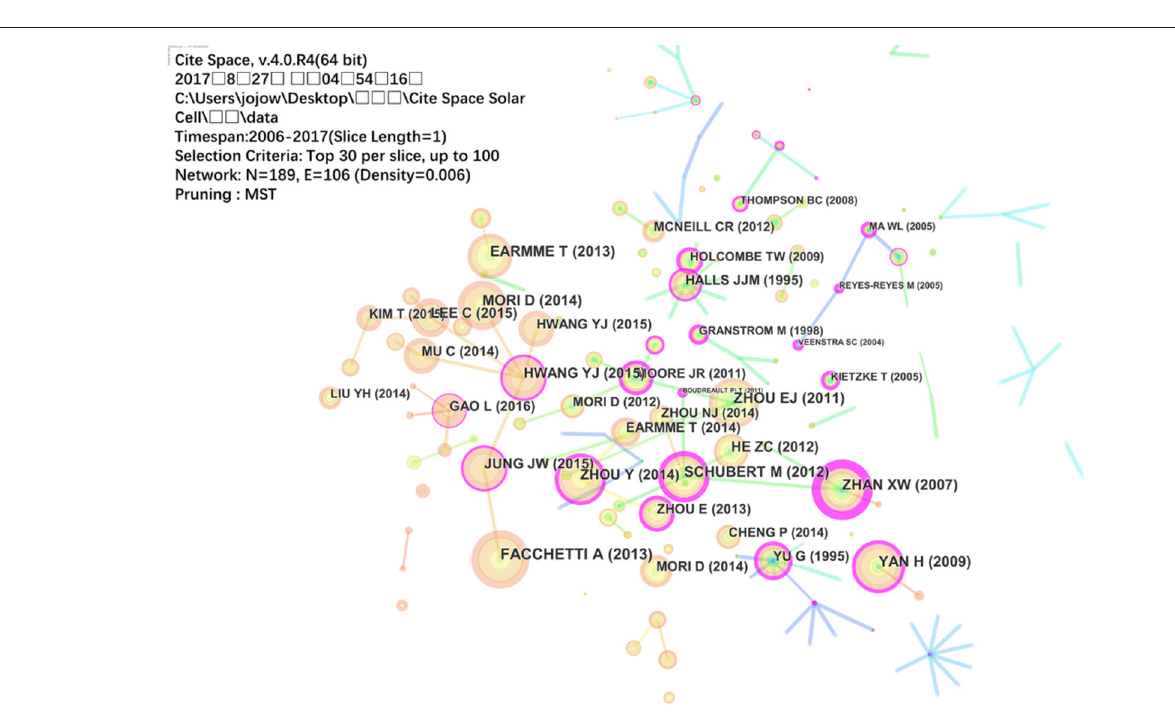
FIGURE 6 | Visualization based on a document co-citation network of all-polymer solar